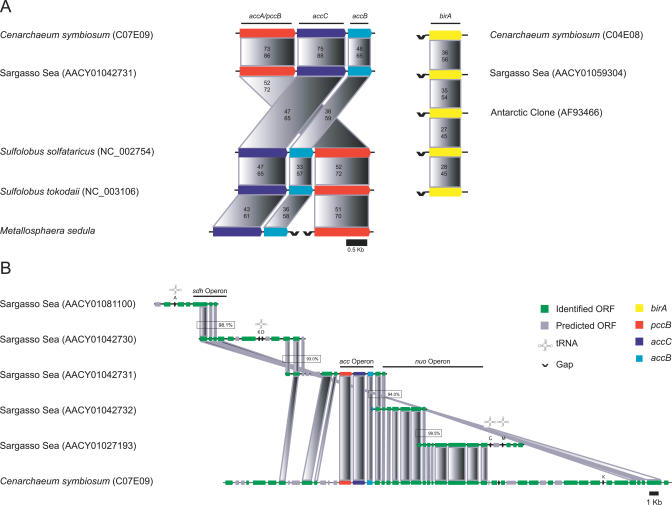
Relationship of
C. symbiosum Acetyl-CoA Carboxylase
(acc) Operon to Other Crenarchaeal Lineages
(A) Protein identity (top) and similarity (bottom) percentages between predicted gene products identified in
C. symbiosum, a contig identified in the environmental database of SAR WGS sequences, and a subset of thermophilic
Crenarchaeota are shown within the corresponding shaded boxes.
(B) Comparison of the genomic interval containing the
C. symbiosum acc operon with several contigs identified in the environmental database of SAR WGS sequences. Genes shared in common between genomic intervals are connected by shaded boxes. Values in clear boxes represent the nucleotide identity between overlapping SAR contigs.